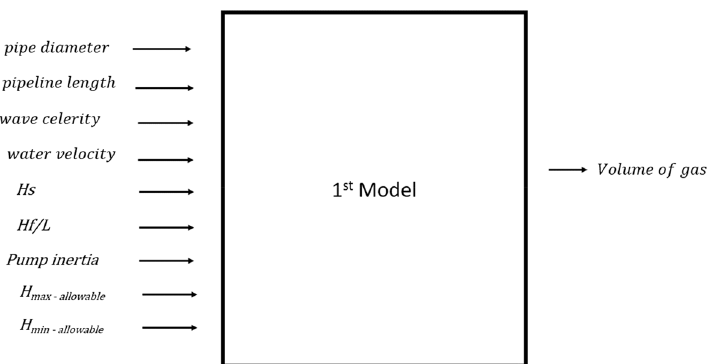
Fig. 8 The 1st model inputs and